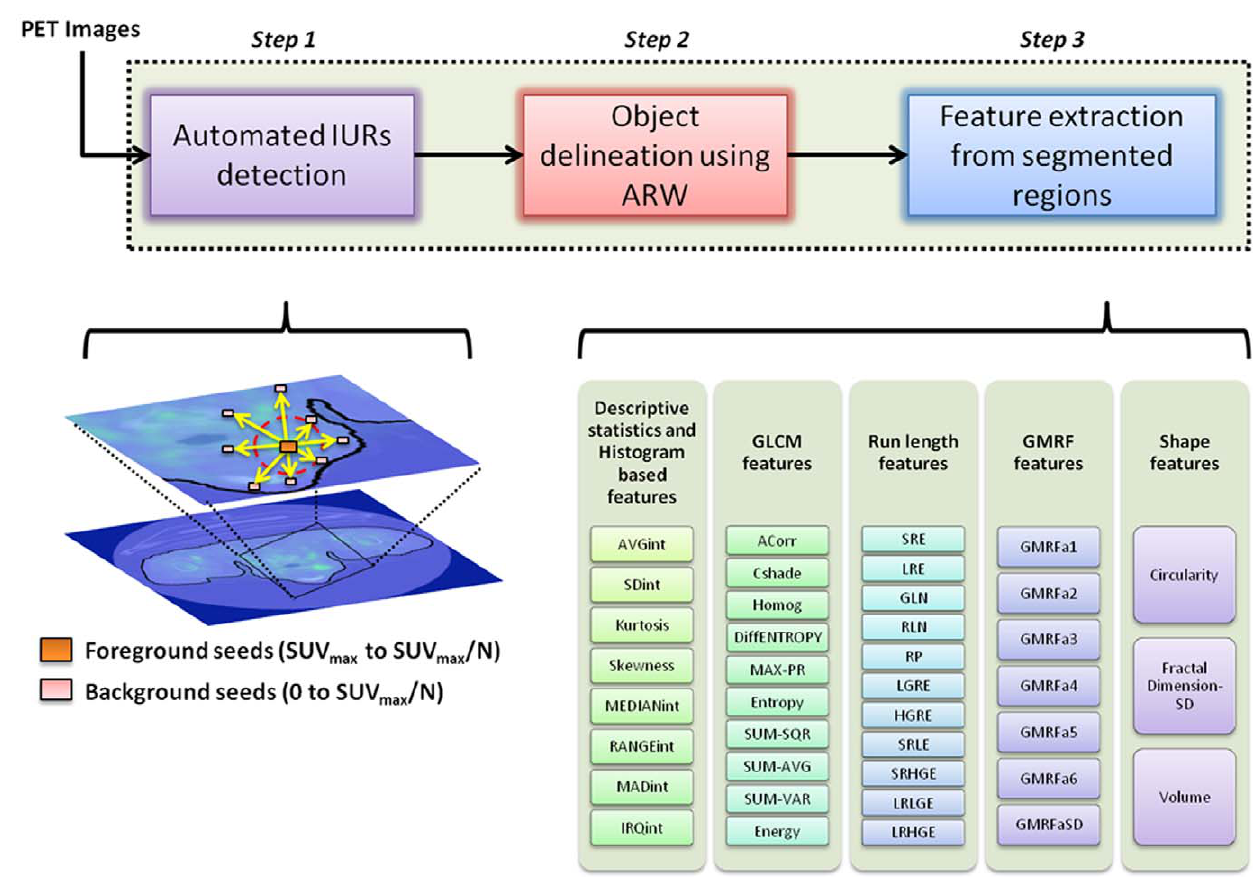
Figure 1. Average intensity (AVGint), standard deviation of intensities (SDint), median value of intensities (MEDIANint), maximum absolute deviation of intensities (MADint), interquartile of intensity histogram (IRQint), Autocorrelation (ACorr), contrast shade (Cshade), homogeneity (Homog), difference of entropy (DiffEntropy), maximum probability (MAX-PR), summation of square of intensity values (SUM-SQR), summation of average of intensity values (SUM-AVG), summation of variation of intensity values (SUM-VAR), short run emphasis (SRE), long run emphasis (LRE), gray level non-uniformity (GLN), run length non-uniformity (RLN), run percentage (RP), low gray level run emphasis (LGRE), high gray level run emphasis (HGRE), short run low gray level emphasis (SRLE), short run high gray level emphasis (SRHGE), long run low gray level emphasis (LRLGE), long run high gray level emphasis (LRHGE).